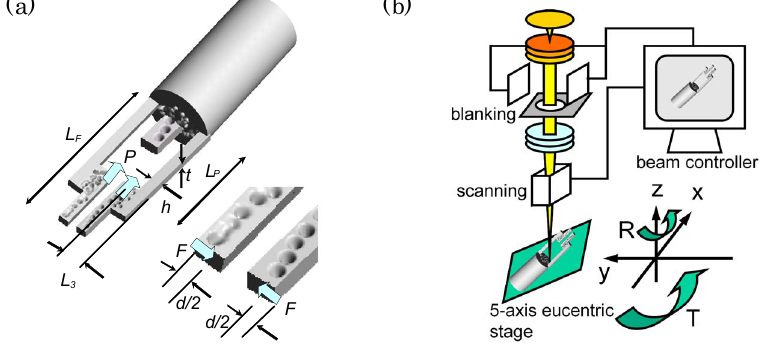
Fig. 2 Microtweezers skeleton. (a) Design of the microtweezers skeleton. The skeleton was fabricated on a section of hair shaft. The beams of the skeleton were bent to the medial side by muscular contraction force P applied at their mid-point. Parameters are listed in Table 1. (b) A Schematic of 3-D rapid prototyping method using FIB-induced ion milling. Beam scanning and the 5-axis eucentric stage were simultaneously controlled to fabricate the 3-D prototype product from biological